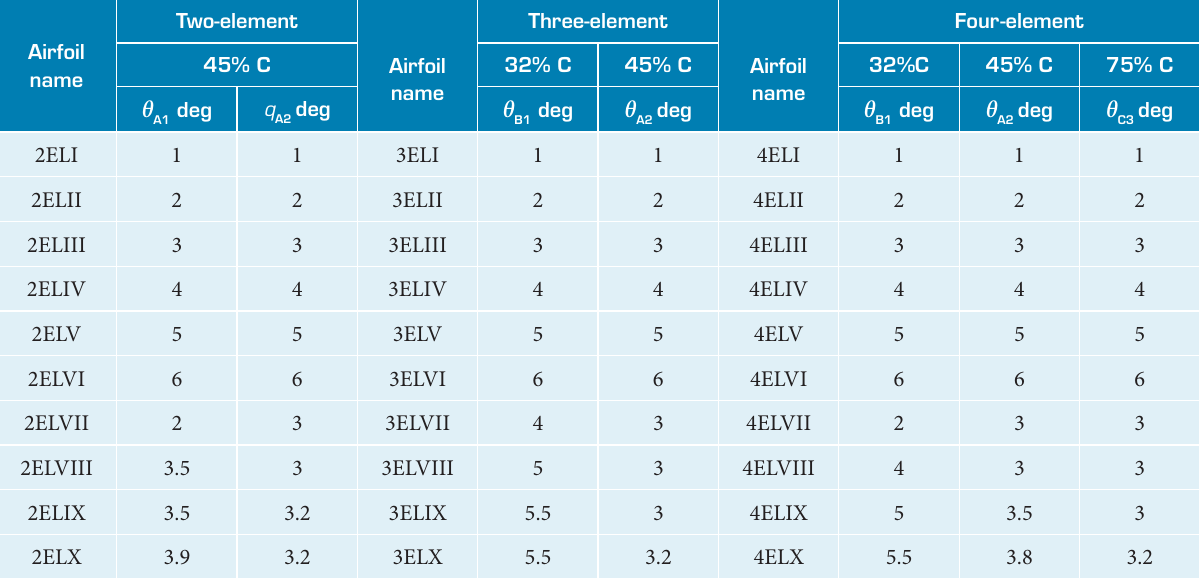
Table 1. Geometric details of morphed airfoil configurations.